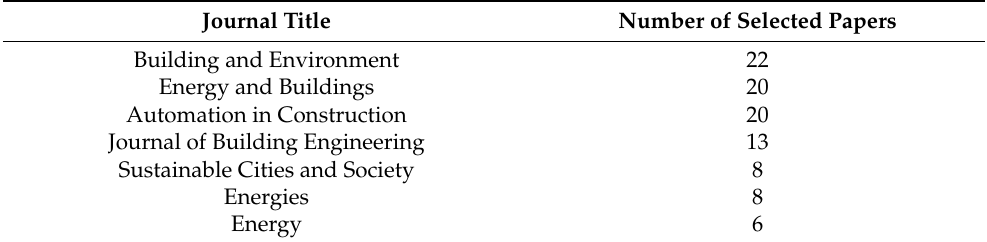
Table 2. Distribution of the selected papers from different article